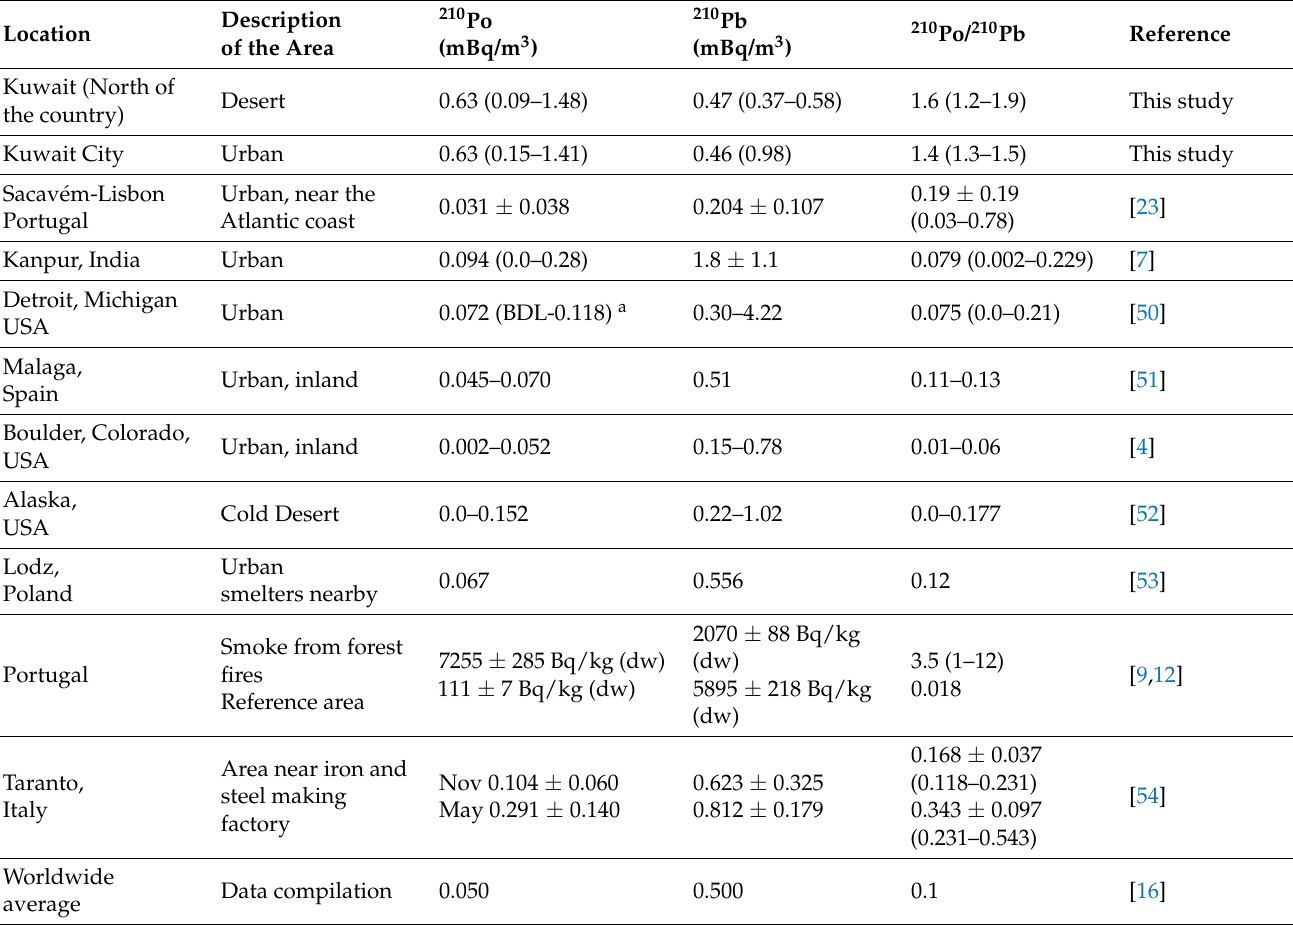
Table 6. Polonium-210 and 210 Pb activity concentrations (mBq/m 3 , or otherwise indicated) and 210 Po/ 210 Pb ratios in surface air at several locations around the